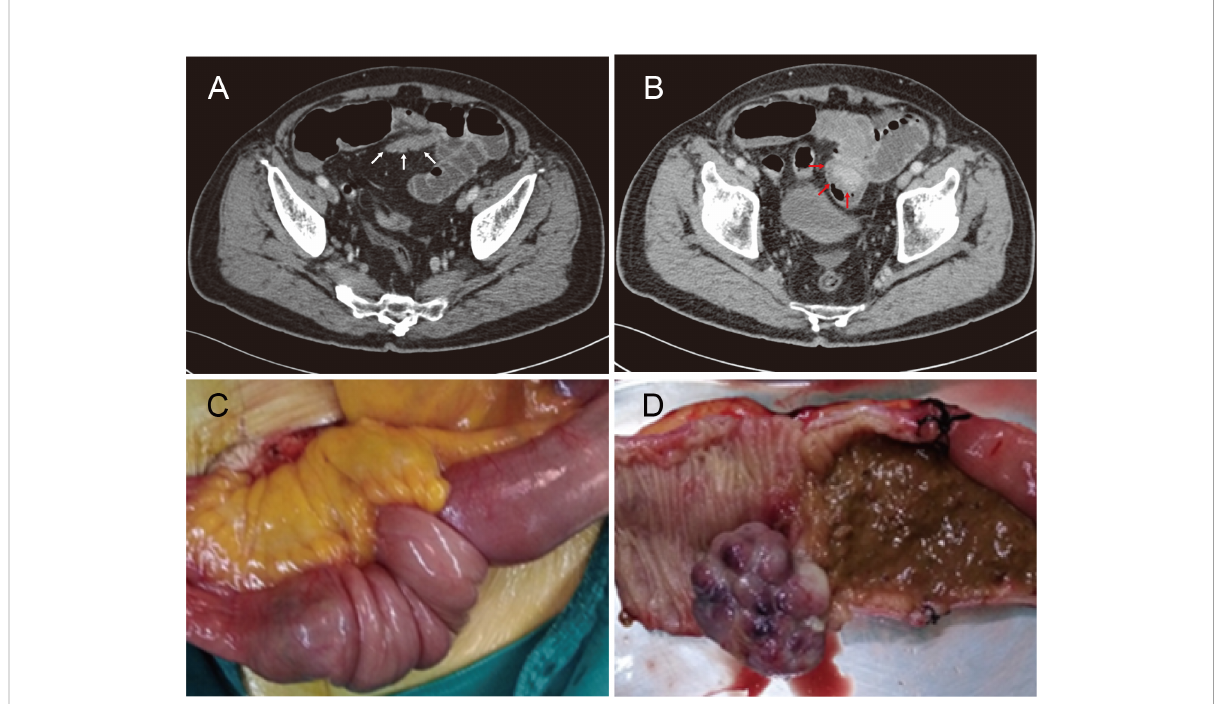
FIGURE 1 (A, B) Computed tomography images demonstrating small bowel obstruction due to intussusception of the distal ileum ( white arrows ) containing an approximately 4 × 4 cm intraluminal soft-tissue mass ( red arrows ). (C) An intraoperative photo con fi rming intussusception whose lead point was a solitary ileal neoplasm. (D) Gross image of the surgical specimen with a 4 × 3 × 3-cm taupe cauli fl ower-like, pedunculated tumor.